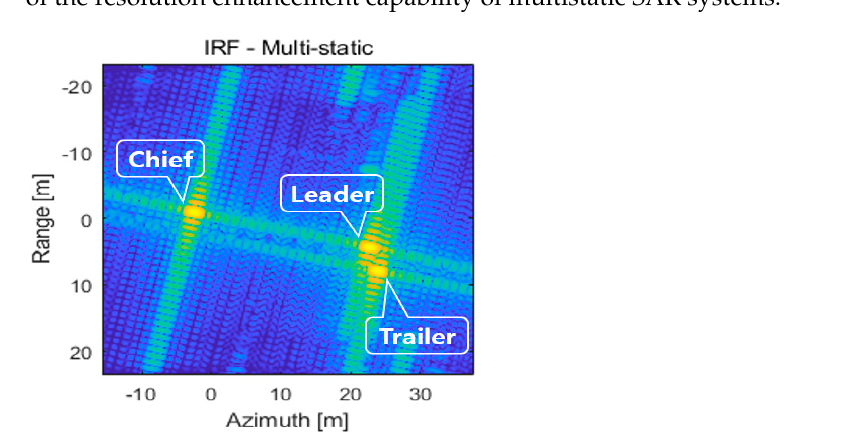
Figure 19. Point target IRF of a multistatic SAR system in the case of a baseline of 6 km and determined orbit.